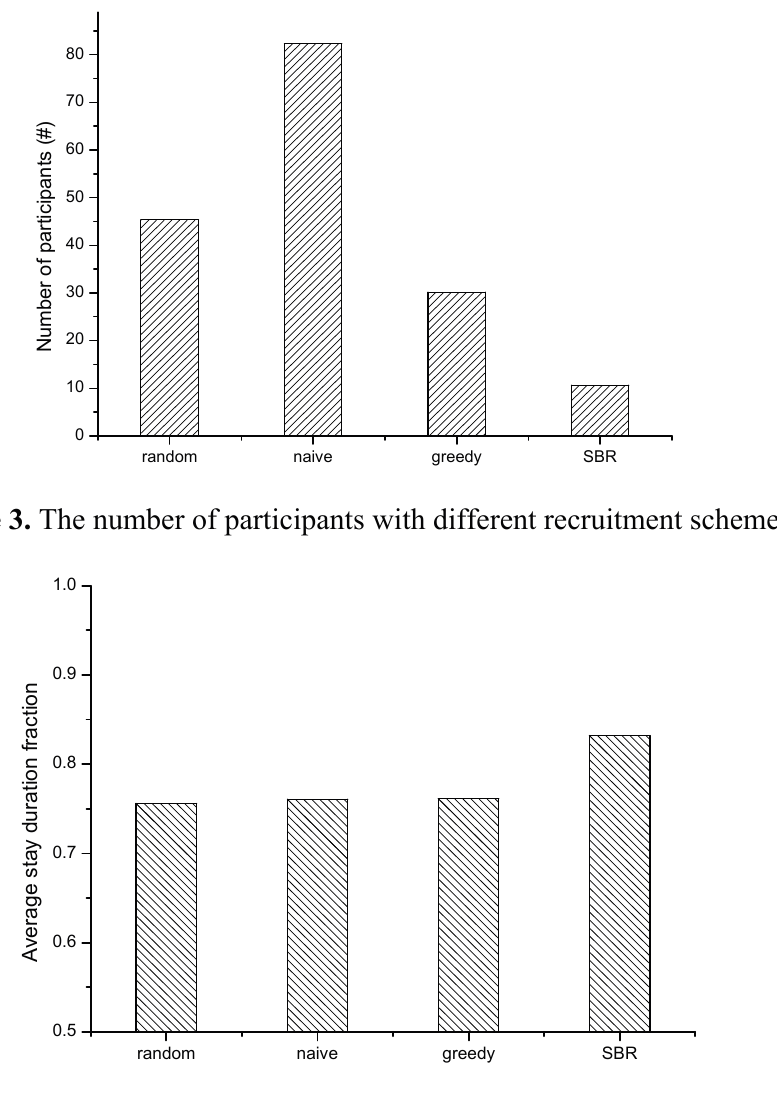
Figure 4. The average stay duration with different recruitment